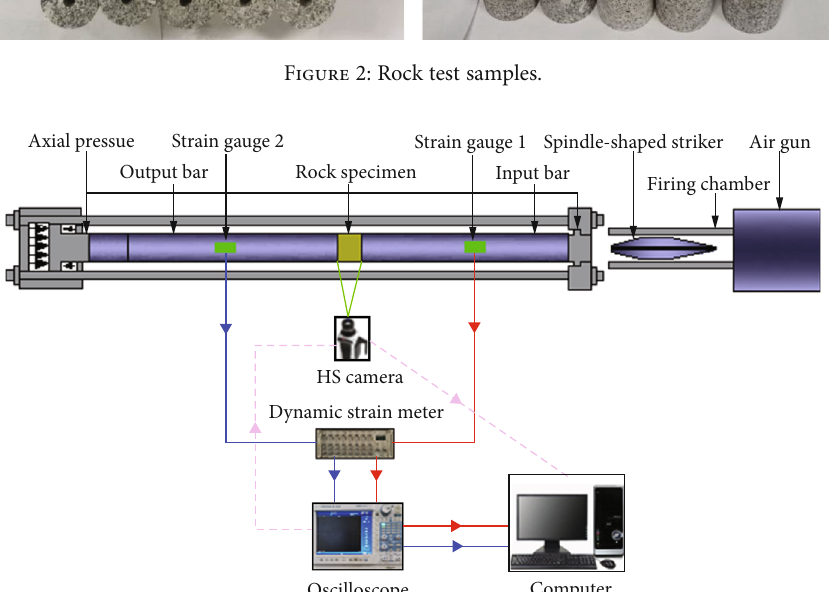
Figure 3: Rock dynamic and static combination based on the SHPB